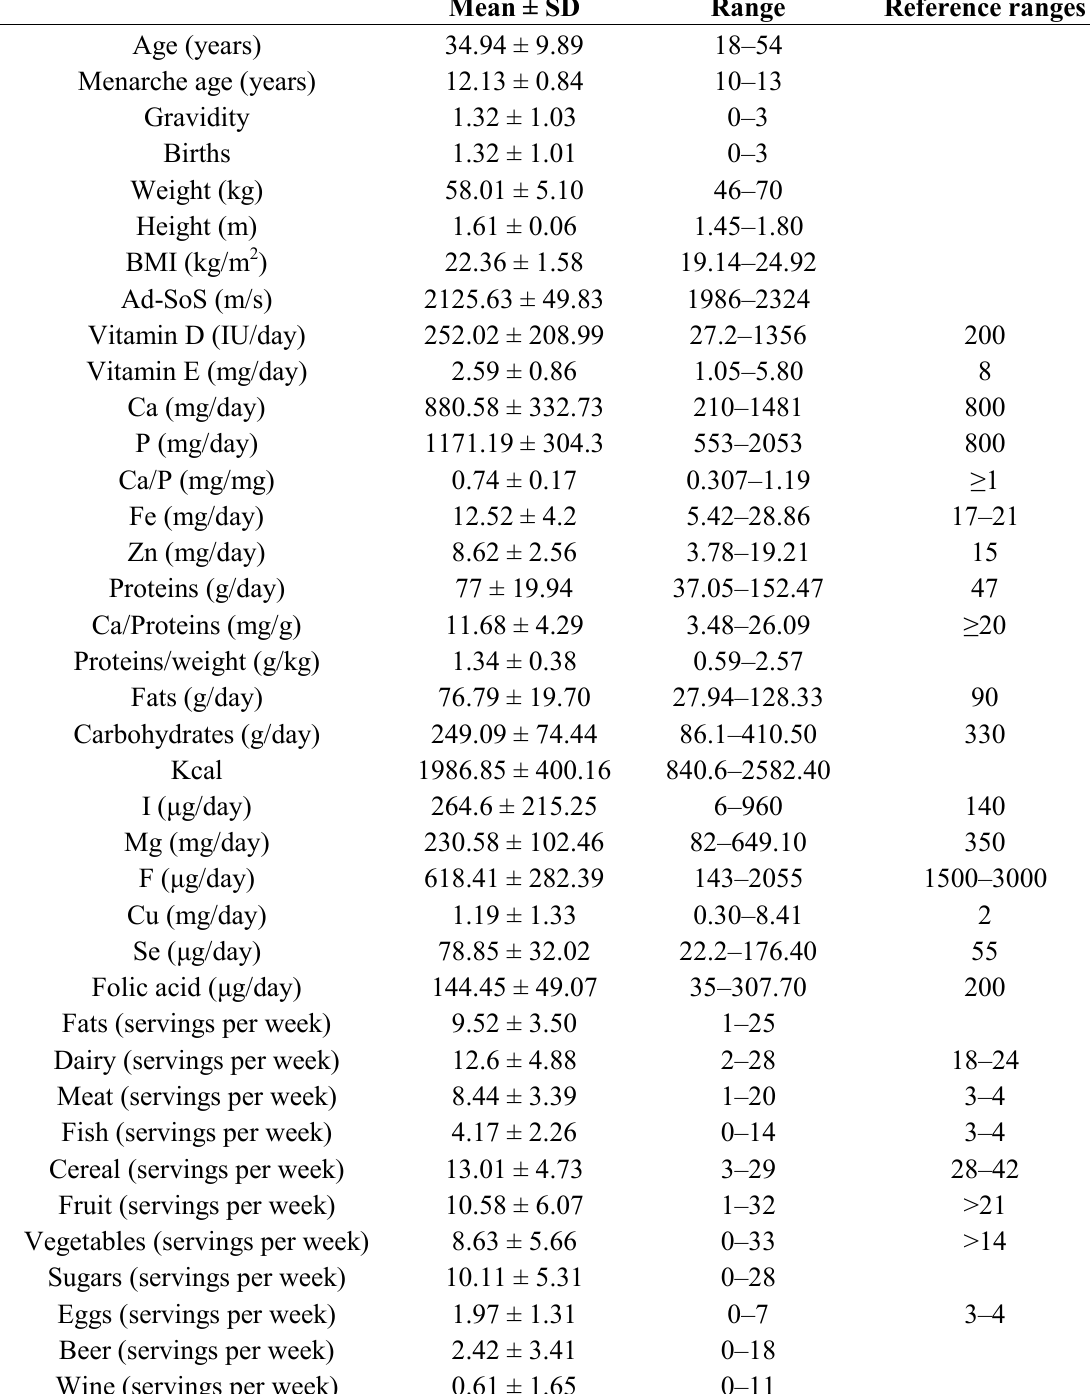
Table 1. Biological, anthropometric and dietetic factors in the studied